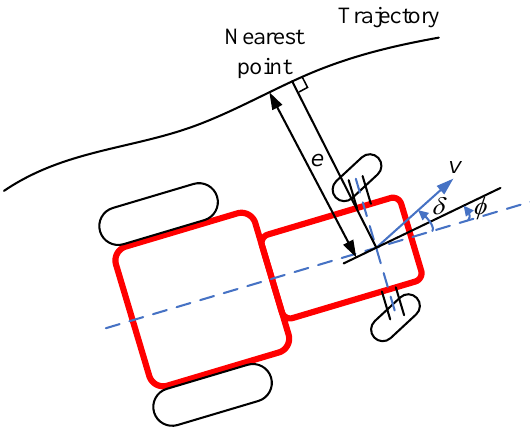
Figure 5. Parameters of the Stanley controller.